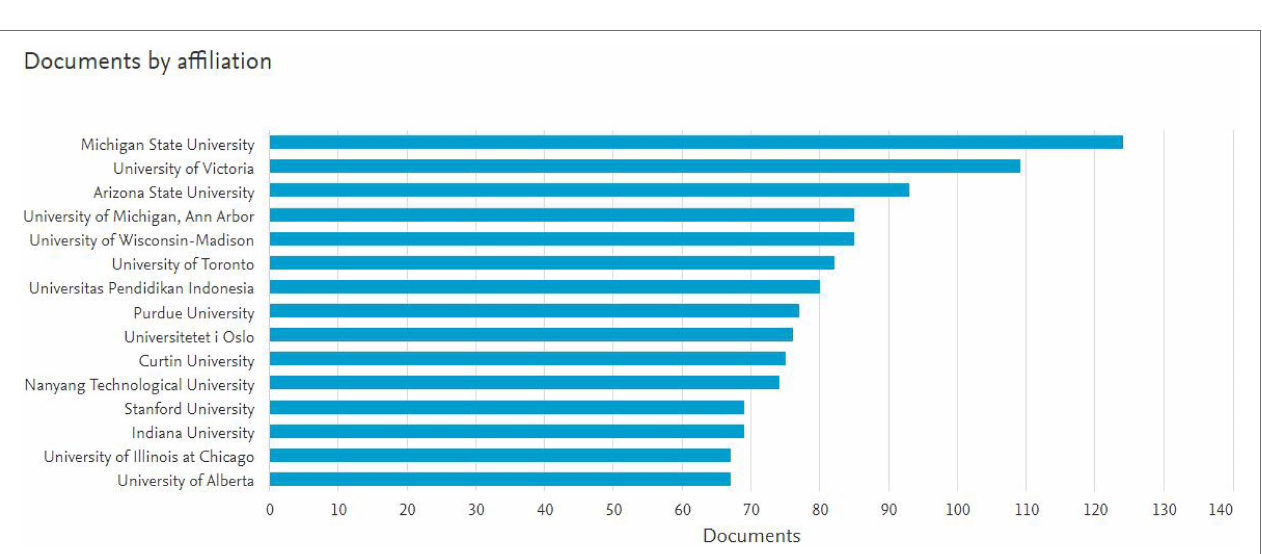
FIGURE 3 | Top 15 institutions as contributors in the field of scientific literacy between the years 1980 to